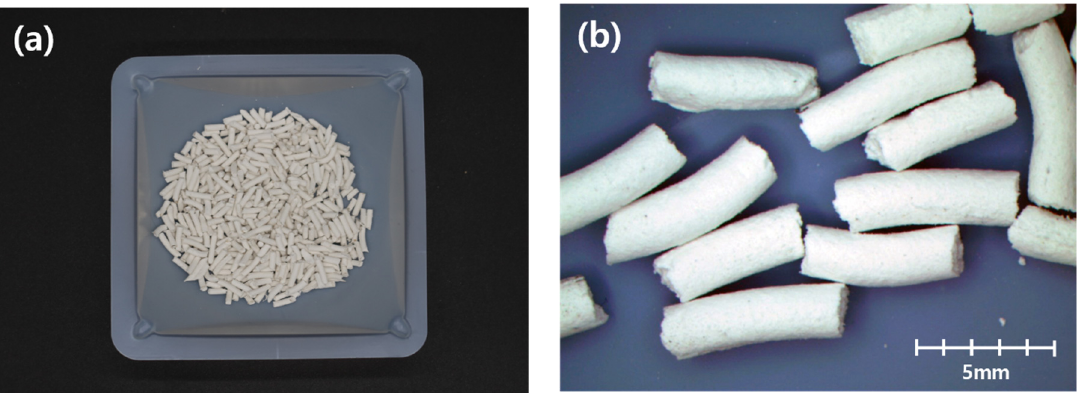
Figure 1. Methylcellulose-based pellet: ( a ) samples of manufactured pellet and ( b ) 20 × magnified image.